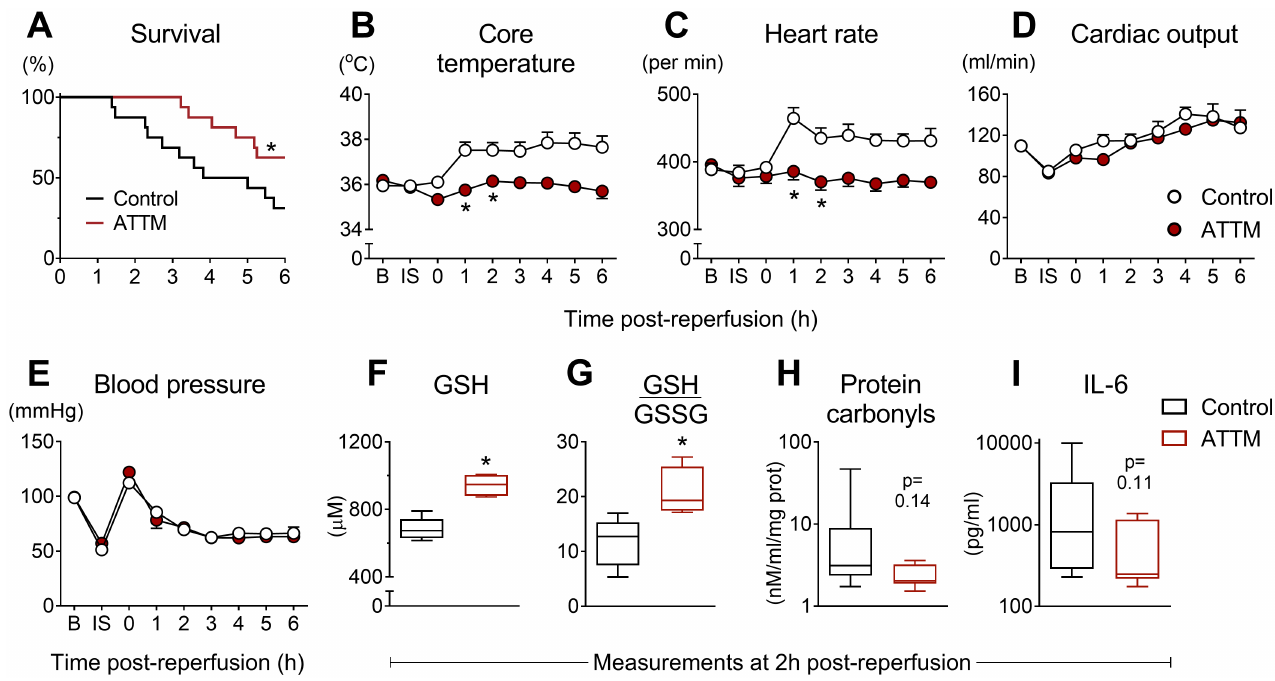
Fig 6. Global ischemia/reperfusion study. Post-reperfusion survival times are shown in (A) for animalstreated with ammonium tetrathiomolybdate(ATTM) versus vehicle(control). * p < 0.05, log-ranktest, n = 16 per group. Sequentialchangesin core temperature, heart rate, cardiacoutput, and blood pressure are shown (B–E). * p < 0.05 using a two-way repeatedmeasuresANOVA plus Bonferronitest. Note that this test was only performed up to 2 h post-reperfusiondue to early mortality. Measurements of (F) bloodlevels of reducedglutathione(GSH; antioxidant reserve capacity), (G) the ratio of GSH to oxidizedglutathione(GSSG) (lowervalues indicategreater oxidativestress), (H) protein carbonyls (oxidative damage), and (I) interleukin-6(IL-6; systemic inflammation) were performed at 2 h post-reperfusion, before the onset of significant mortality. * p < 0.05, unpaired t